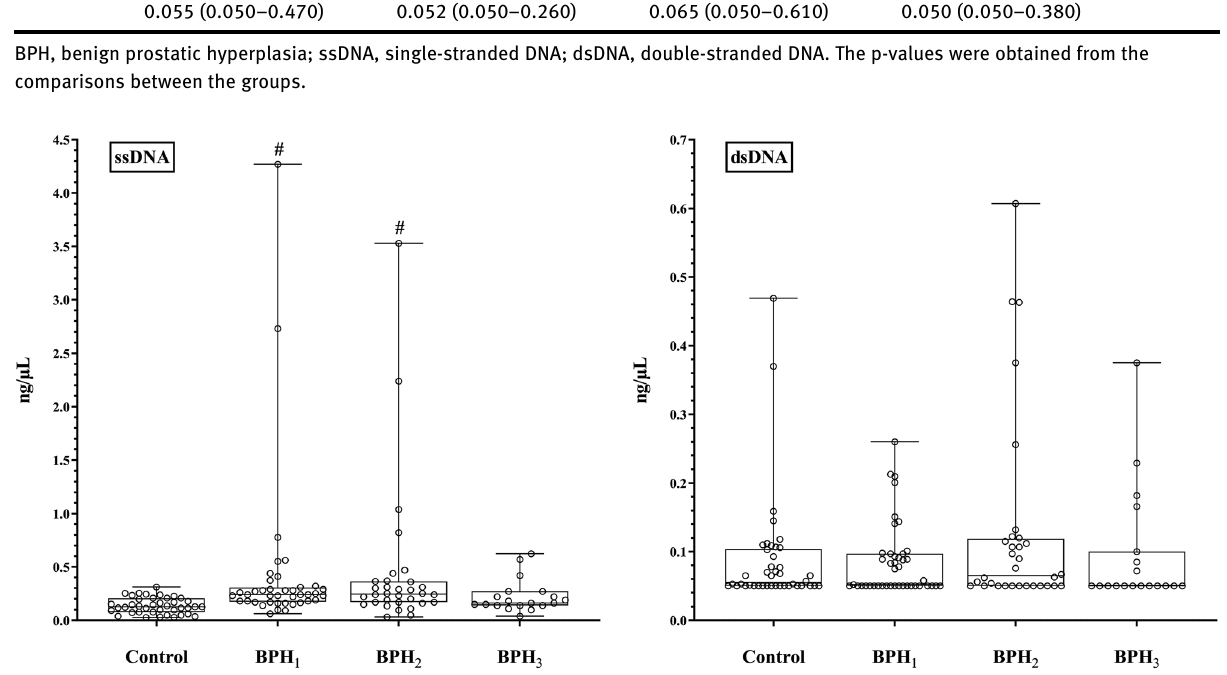
Figure 2: Graphical comparison of the dsDNA amounts in the control, preoperative (BPH 1 ) and postoperative (BPH 2 and BPH 3 ) samples of the